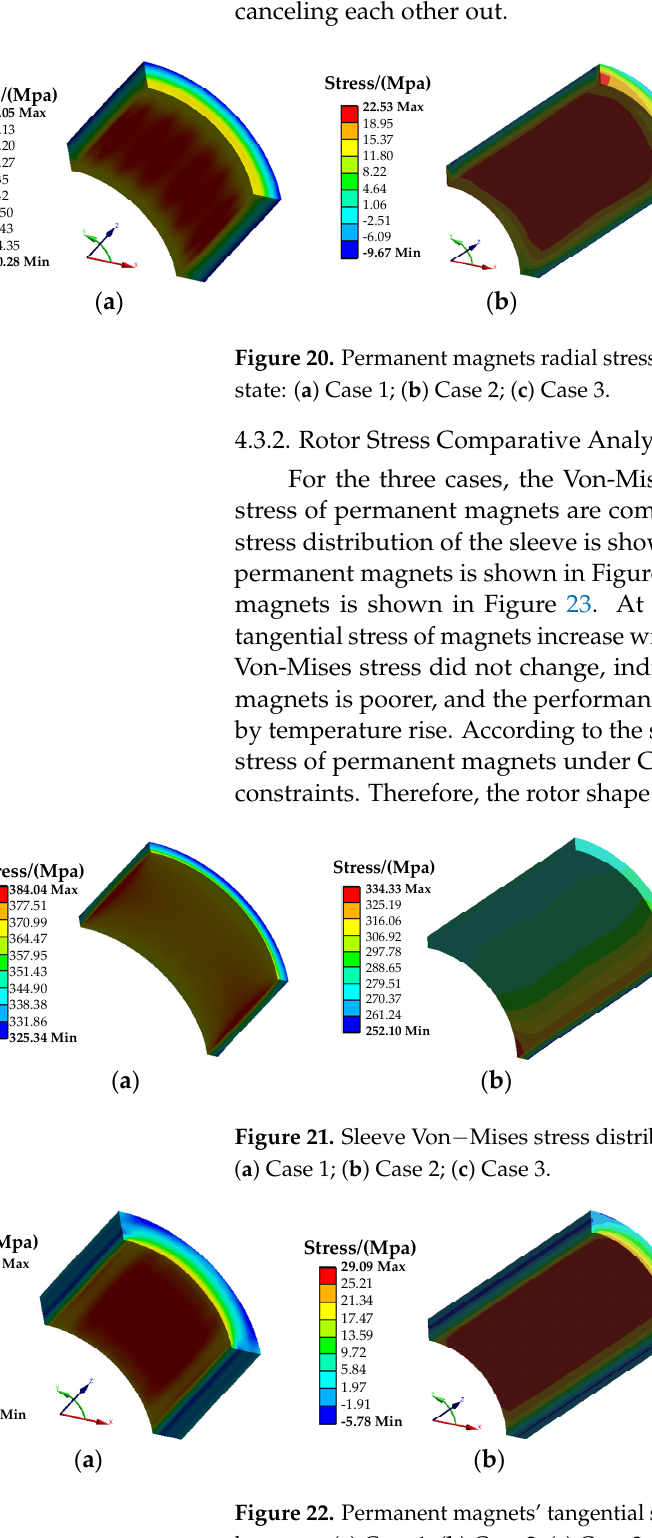
Figure 19. Permanent magnets tangential stress distribution under the three cases at rated speed at a cold state: ( a ) Case 1; ( b ) Case 2; ( c ) Case 3.